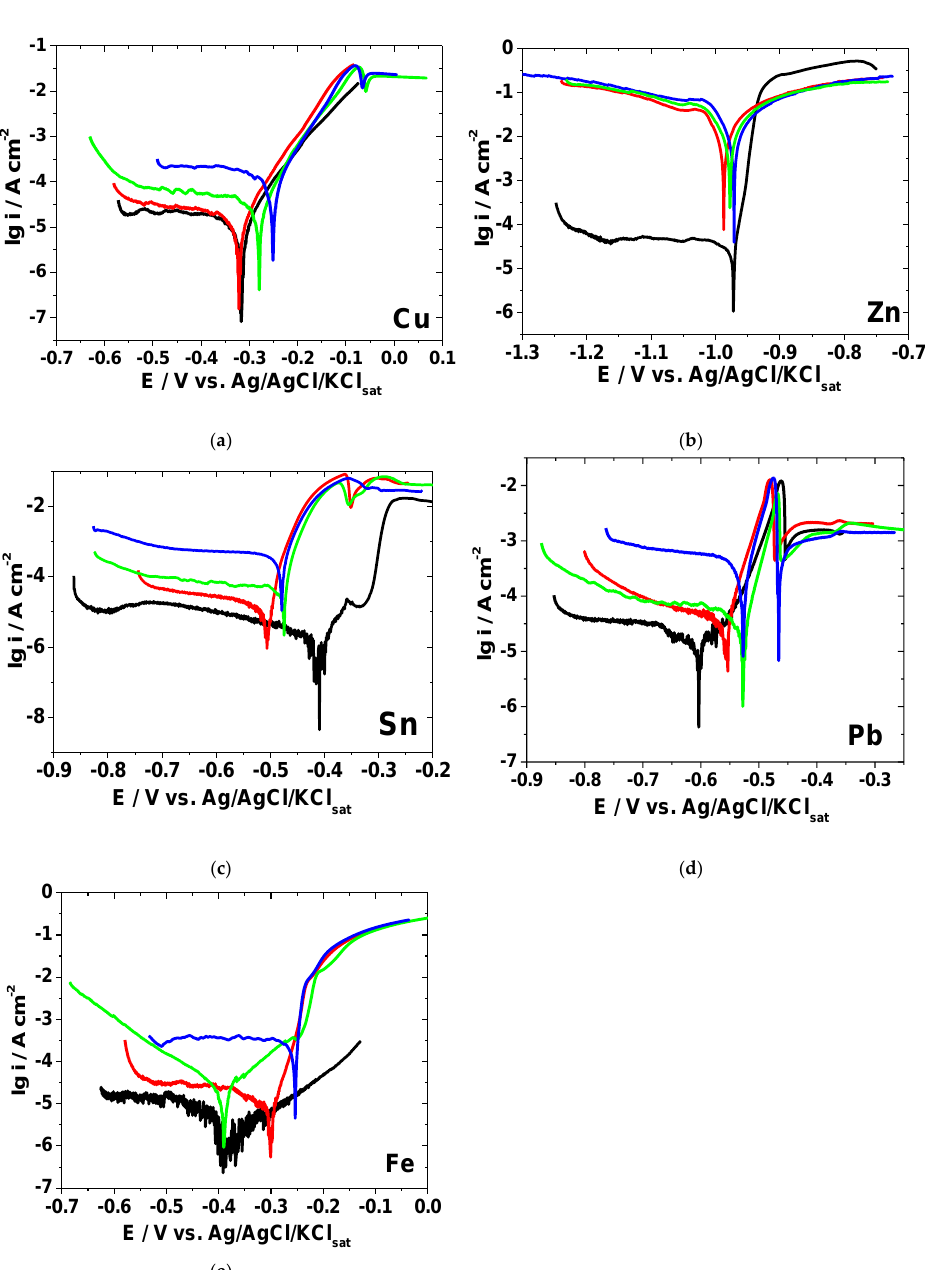
Figure 1. Polarization curves collected after 1-h immersion of electrodes in different bromide-based electrolytes: Cu ( a ); Zn ( b ); Sn ( c ); Pb ( d ); and Fe ( e ). (—) Sol. A, ( — ) Sol. B, ( —) Sol. C, ( — ) Sol. D.